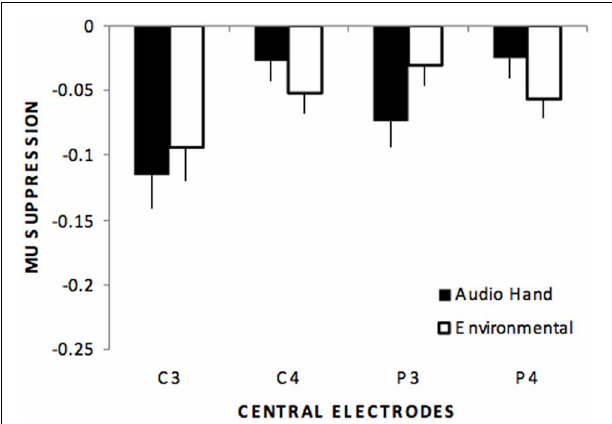
FIGURE 3 | Mu suppression over centro-parietal regions (C3, C4, P3, P4) showing that although no differences occurred between these sounds (audio hand vs. environmental), a stimulus type by electrode interaction showed that audio hand sounds exhibited greater suppression over left hemisphere sites (C3, P3) while environmental sounds exhibited greater suppression over right hemisphere sites (C4, P4).